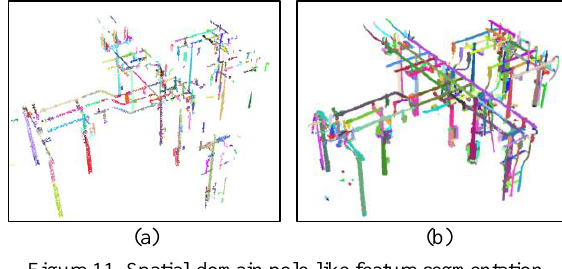
Figure 11. Spatial-domain pole-like feature segmentation results: (a) from a single TLS scan and (b) from multiple registered TLS